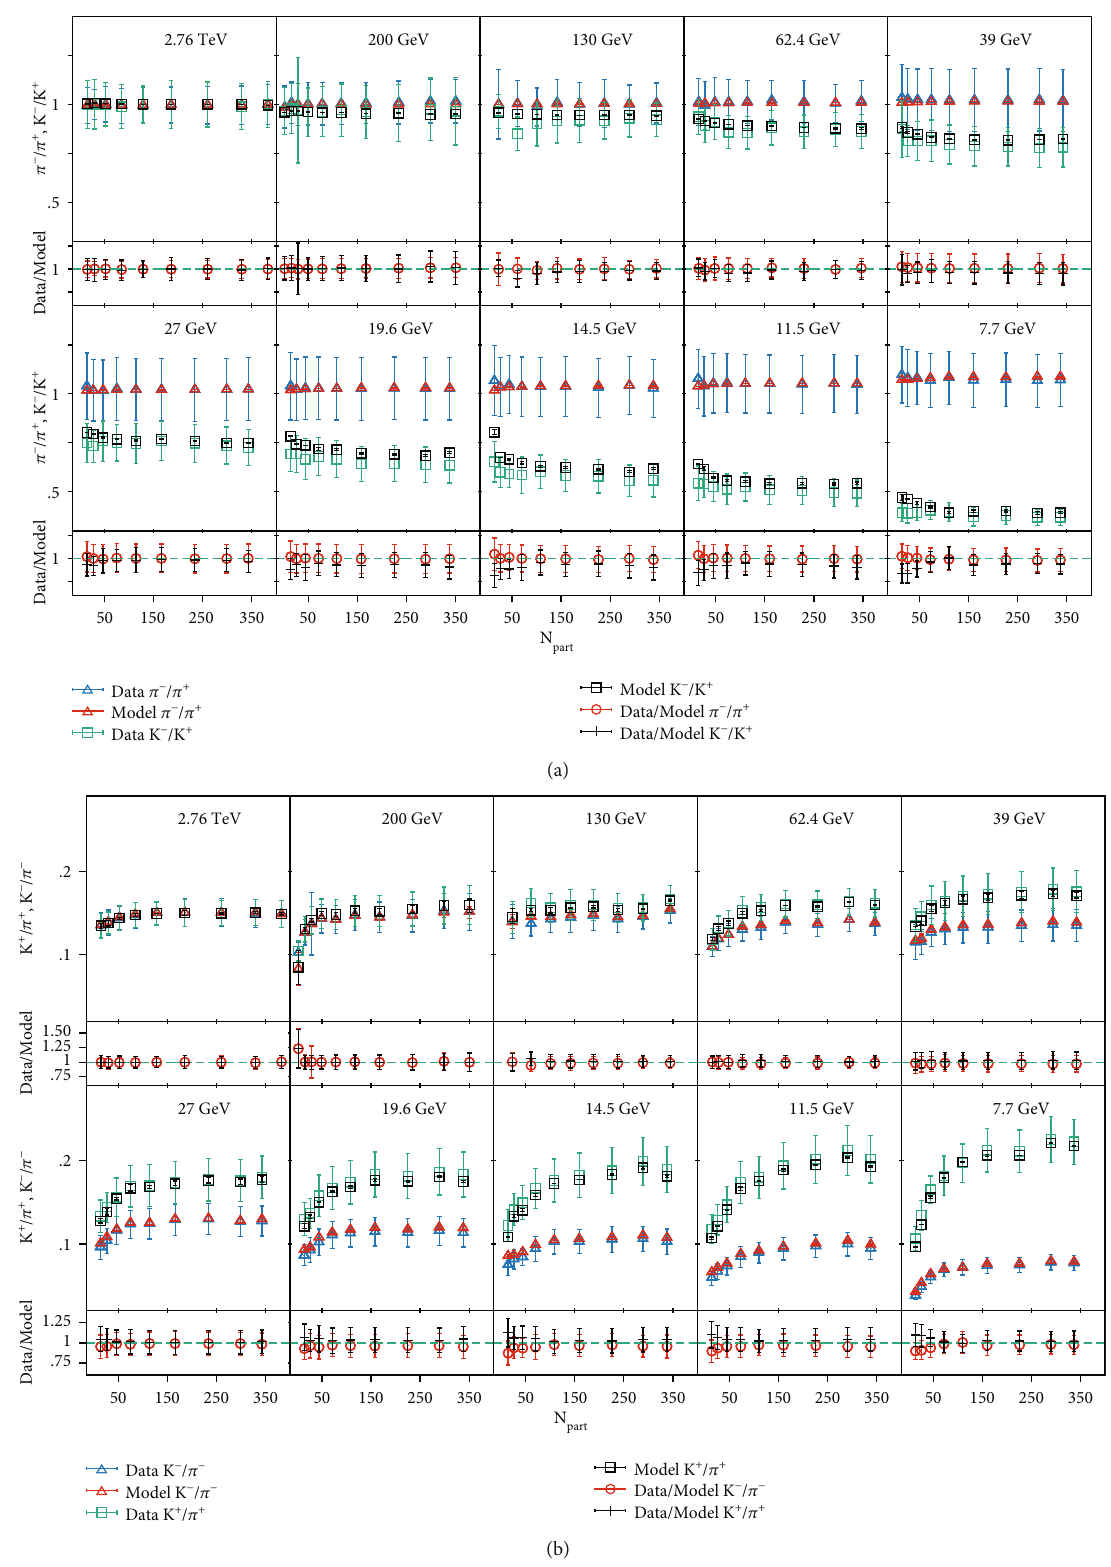
π − / π + , K − / K + (upper panel) and K + / π + , K − / π − (lower panel) for di ff erent collision energies Figure 5: (Color online) N part dependency of ffiffiffiffiffiffiffiffi p ( ). Experimental data (blue and green) are from RHIC [6], RHIC-BES [66, 69], and LHC [68]. Model estimations are calculated s NN from freeze-out parametrization. Ratio between the data and model are given below each